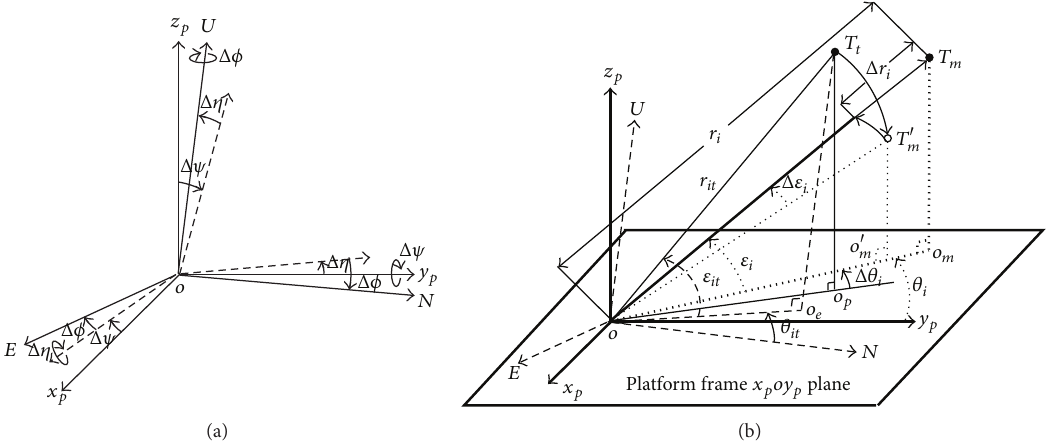
Figure 2: (a) Conversion from the platform frame to ENU and (b) measurement in platform frame.